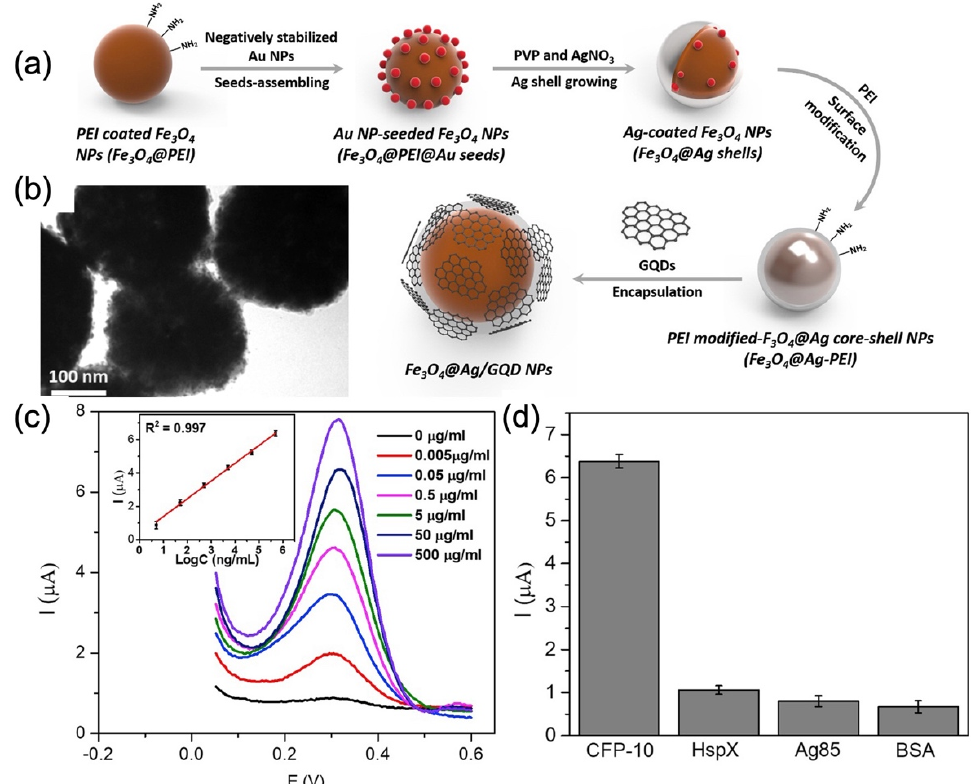
Figure 31. ( a ) Preparation steps for the Fe 3 O 4 @Ag/GQD NP probe. ( b ) TEM image of Fe 3 O 4 @Ag/GQD NPs. ( c ) Peak value of the electrochemical biosensor for CFP-10 detection at concentrations ranging from 0 to 500 μ g/mL. ( d ) DPV responses of the immune sensors to CFP-10 (0.5 mg/mL), HspX pro- tein of Mtb (1.8 mg/mL), Ag85 (3.57 mg/mL), and 2% BSA (3.57 mg/mL). Adapted with